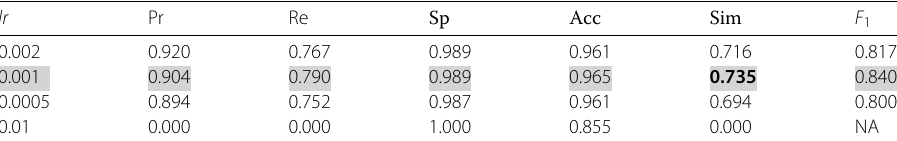
and S 2000 with λ = 0.0001 aug